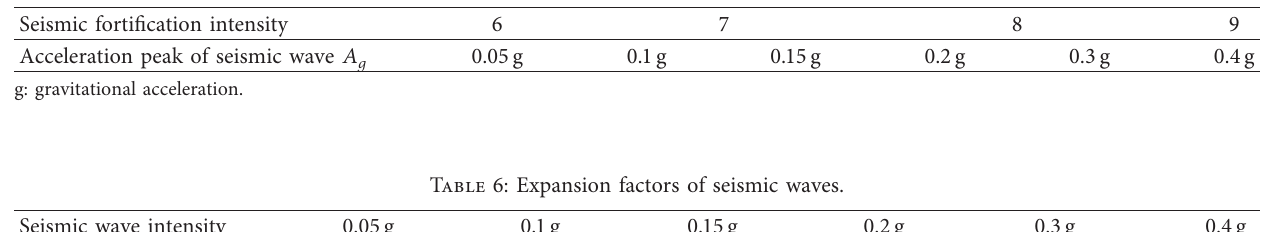
Figure 12: Time history of the Qian’an wave. (a) Lateral acceleration-time curve. (b) Lateral velocity-time curve. (c) Lateral displacement- time curve. Table 5: Seismic fortification intensity and acceleration peak of seismic wave.